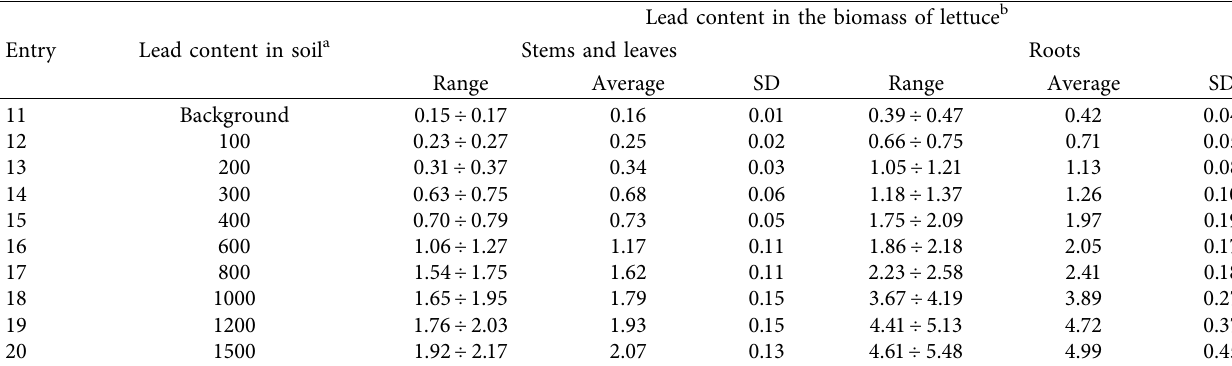
Table 4: Concentration of lead in this metal-contaminated soil and in the biomass of lettuce grown in this soil.